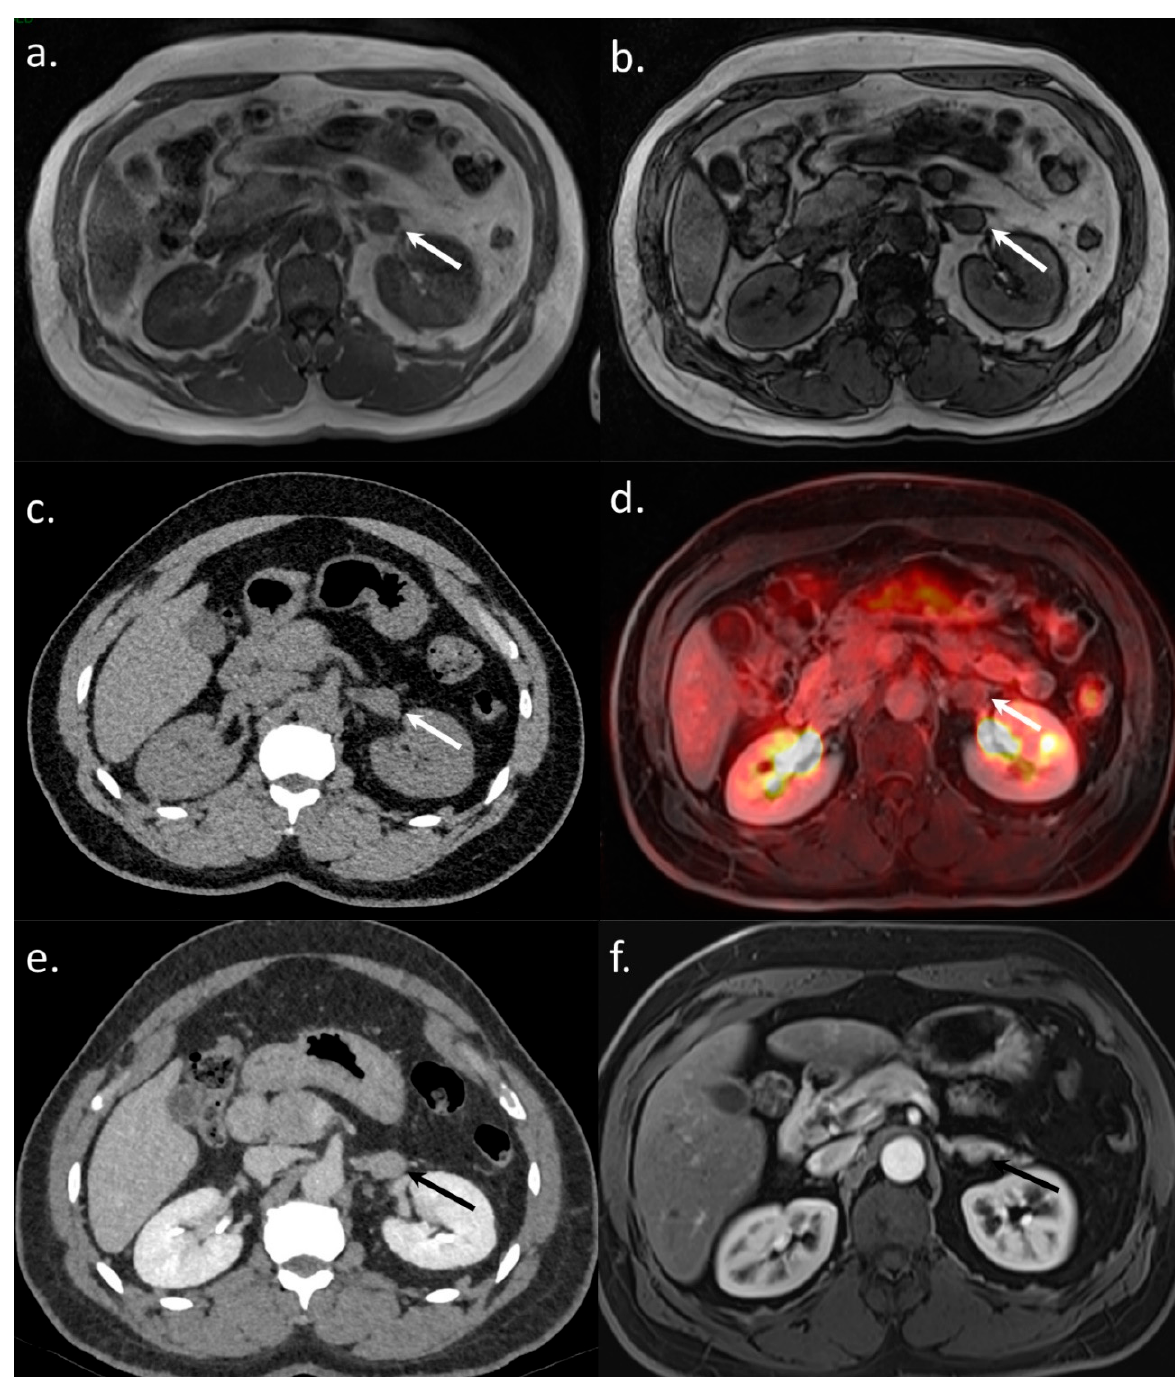
Figure 5. A 61-year-old BCLC A patient referred for a WB-PET/MRI before liver surgery for HCC. On the liver MRI, a 2 cm large left adrenal nodule was observed without signal drop on out phase images ( a , b ). On the CT-CAP, the unenhanced adrenal mass density was 39UH, which was not able to confirm its benign nature ( c ). No hypermetabolism was observed on 18 F-FDG-PET ( d ), leading to the exclusion of its metastatic nature. Surgery was performed and the adrenal lesion remained stable on the followup CT ( e ) and MRI ( f ) performed three and nine months after the WB-PET/MRI, respectively.